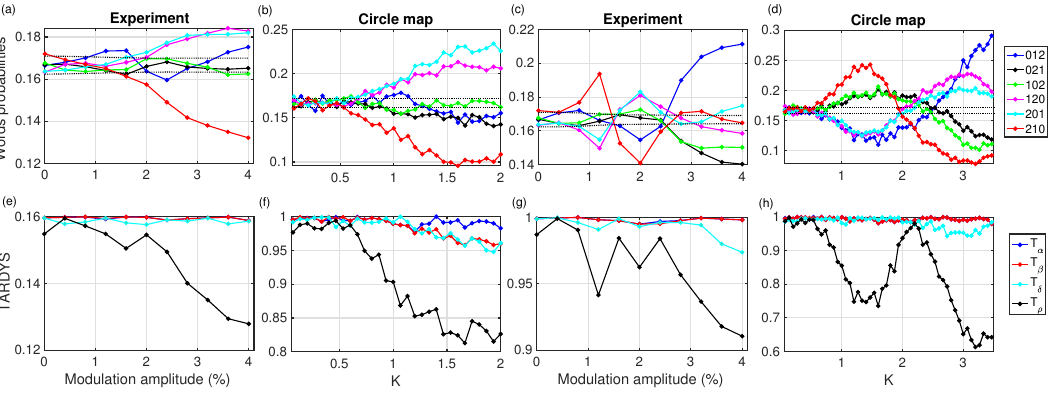
Figure A2. Experiments with photonic neurons for f = 11 MHz ( a , e ) and f = 25 MHz ( c , g ); and simulations using the circle-map model ( b , d , f , h